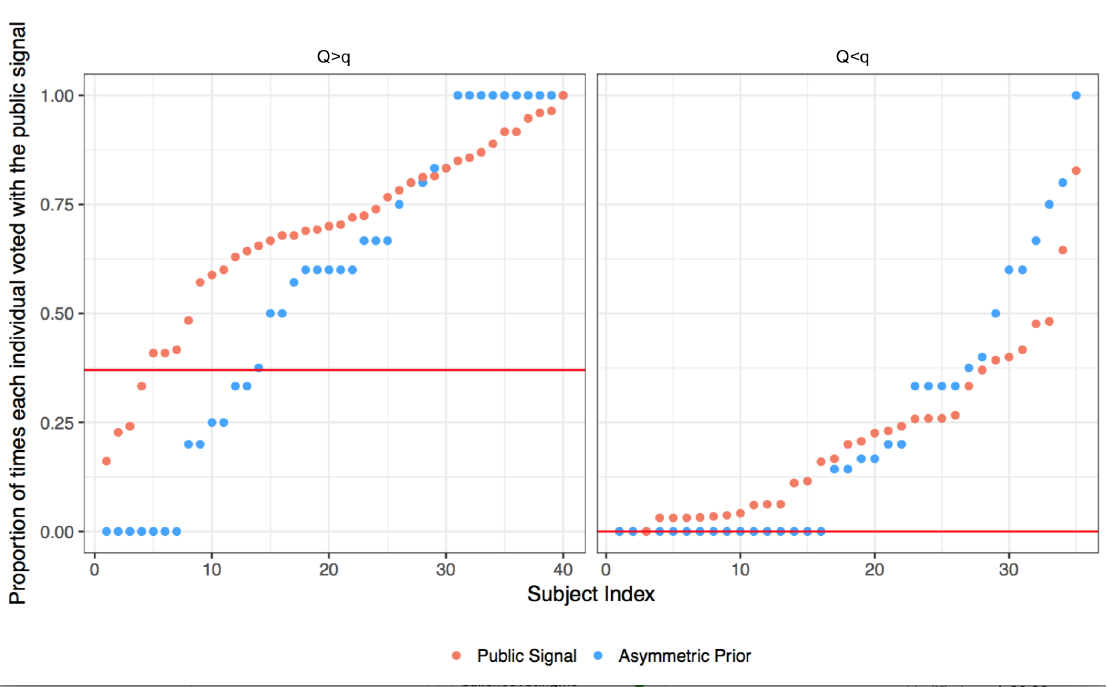
Figure A6. Asymmetric Prior (group task): Proportion of times each individual voted according to the public signal. The left image plots values for sessions where Q > q , the right one Q < q . Red dots correspond to the public signal delivered, blue dots to public signal conflated in the